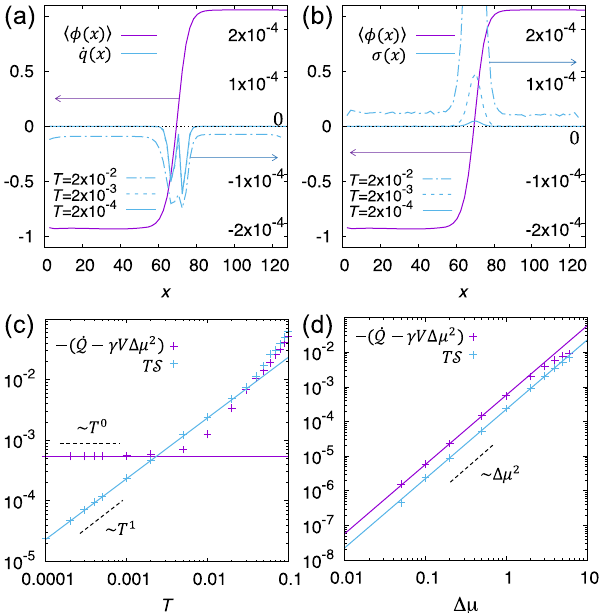
FIG. 3. (a),(b) The average profile of density h ϕ ð x Þi shows a separation between dilute [ h ϕ ð x Þi < 0 ] and dense [ h ϕ ð x Þi > 0 ] phases. The corresponding profiles of heat rate _ q ð x Þ and of irreversibility measure σ ð x Þ , given, respectively, in Eqs. (33) and (39), are flat in bulk regions and vary rapidly across the interface. R _ Q − γ V Δ μ 2 _ qdx (c) The nontrivial contribution to heat rate ¼ V reaches a finite value at T ¼ 0 , whereas the irreversibility measure R T S ¼ σ dx vanishes. (d) _ Q − γ V Δ μ 2 and T S increase and V decrease, respectively, with the driving parameter Δ μ , and both scale as Δ μ 2 . Simulation details in Appendix D.